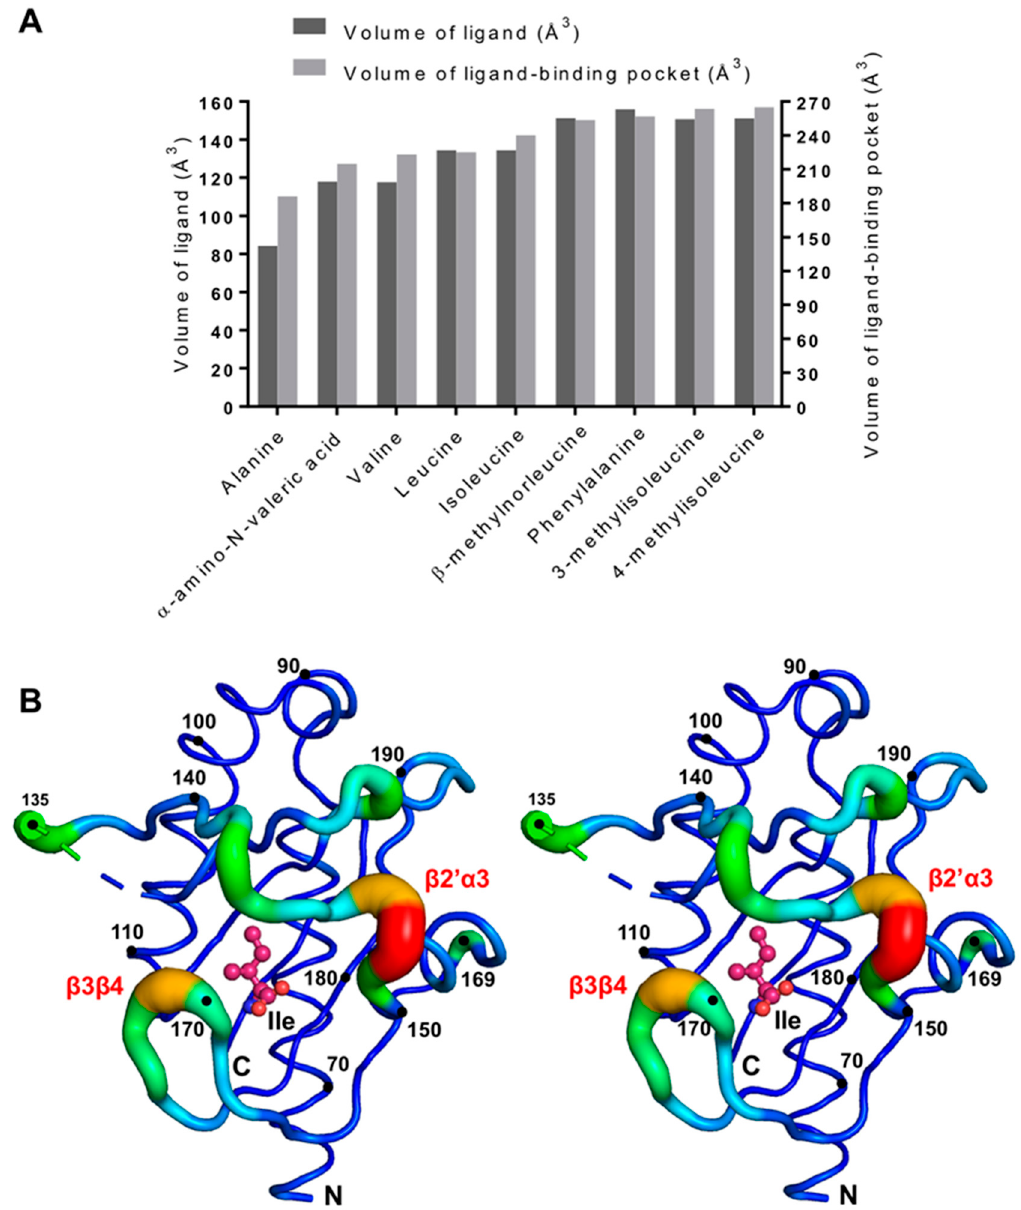
Figure 8. Analysis of plasticity of ligand-binding pocket in Tlp3 LBD. ( A ) Comparison of the volumes of the ligand-binding pocket of Tlp3 LBD in complexes with different ligands. It is apparent that the pocket expands according to the size of the ligand. Ligand volumes were calculated using Molinspiration (http://www.molinspiration.com/cgi-bin/properties). ( B ) Stereo diagram showing residues 63–197 of the Tlp3 LBD/isoleucine complex, drawn with the backbone radius proportional to the residue-by-residue C α RMSD to the mean structure for the superimposition of membrane-distal subdomains of subunit B from all nine available Tlp3 LBD complexes. The colour gradient runs from blue (the smallest RMSD) to red (the largest RMSD). The largest displacements of C α atoms were observed for residues Asp143 (0.65 Å), Leu144 (0.56 Å), Lys147 (0.58 Å), Thr148 (0.74 Å), and Lys149 (0.37 Å) from loop β 2’ α 3, and Val171 (0.63 Å), Leu172 (0.40 Å), and Lys173 (0.39 Å) from β -tongue β 3 β 4. The RMSD values were calculated using Superpose from the CCP4 suite [67].